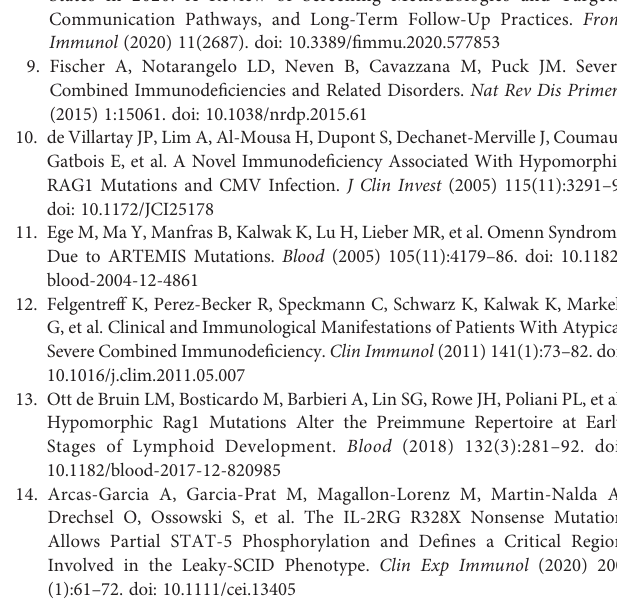
Supplementary Figure 1 | Flow cytometry of PBMCs of the patient ’ s family shows no aberrant phenotype compared to an adult healthy control. (A) Flow cytometry analysis of T and B lymphocytes in the peripheral blood of the mother (II- 2) and maternal grandfather (I-2) compared to an adult healthy control. Numbers indicate the percentage of the gated populations. HC: Healthy Control. (B) Flow cytometry analysis of peripheral NK lymphocytes and their CD56 expression level. Numbers indicate the percentage of gated populations. Numbers in histograms indicate the geometric Mean Fluorescence Intensity (MFI) of CD56 expression. Supplementary Figure 2 | All 9 canonical protein-coding DCLRE1C transcripts are predicted to be impacted by the c.465-1G>C variant through the generation of an in-frame PTC. The DCLRE1C gene encodes for 16 transcripts of which 13 are protein-coding. 4 of these protein-coding transcripts translate into 4 small proteins which are only predicted models by the Ensembl genome browser and the Uniprot repository. The other 9 protein-coding DCLRE1C transcripts will encode the 4 main human ARTEMIS protein isoforms detected in vivo. Un fi lled boxes: untranslated regions (UTRs). Filled boxes: coding exons. Connecting lines: introns. The 3 ’ UTR is not depicted since this region is rather large to include in this fi gure. The location of the variant is indicated by the red